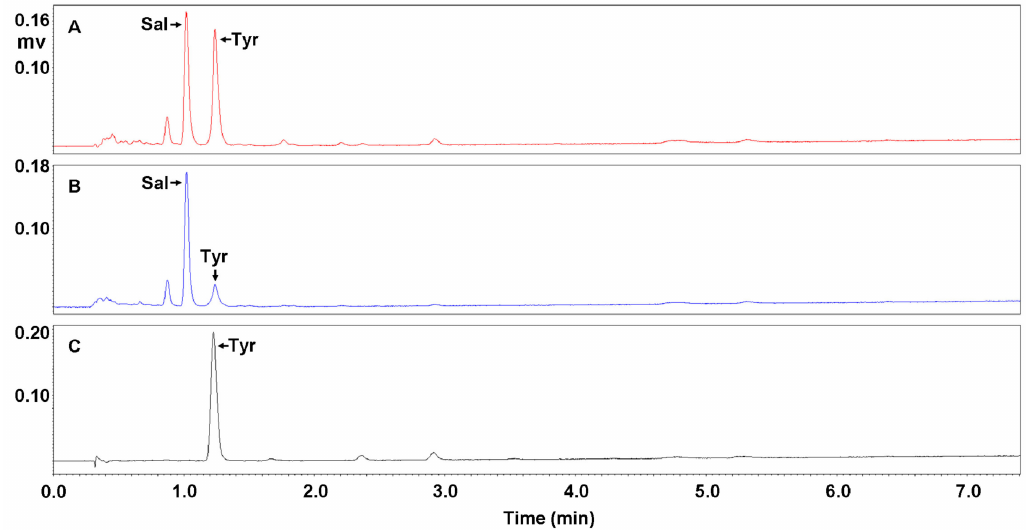
Figure 5. UPLC profiles of extraction with a single chloroform. Shown in sequence are profiles of fractions enriching salidroside and p -tyrosol (i.e., FEST in water) ( A ), aqueous FEST after extraction ( B ), and chloroform after extraction ( C ). Ordinates were proportionally adjusted for comparison. Sal and Tyr refer to salidroside and p -tyrosol,